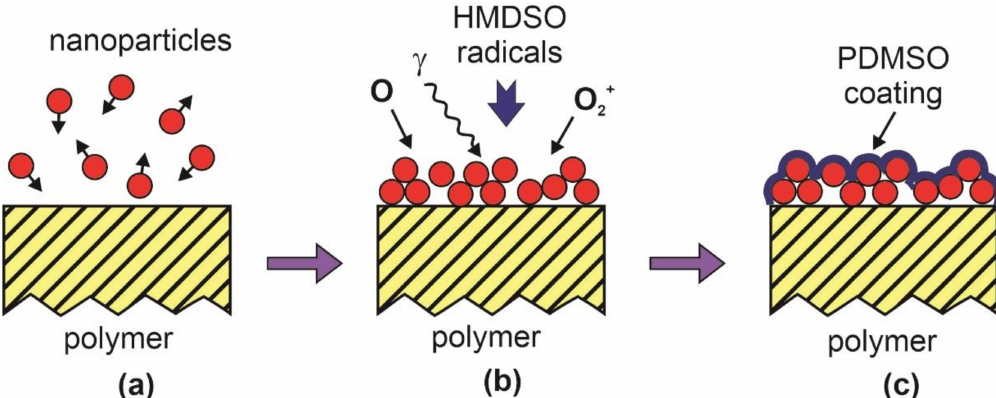
Figure 4. Schematic of a method for hydrophilization of polymers by deposition of a thin coating of nanoparticles followed by deposition of carbon-depleted PDMSO-like coating. ( a ) Deposition of nanoparticles, ( b ) treatment of a layer of deposited nanoparticles in O 2 plasma with admixed HMDSO, and ( c ) formation of PDMSO coating on the layer of